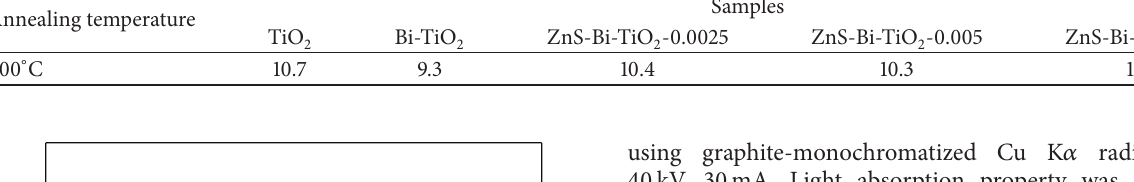
Table 1: Crystallite size (nm) of TiO